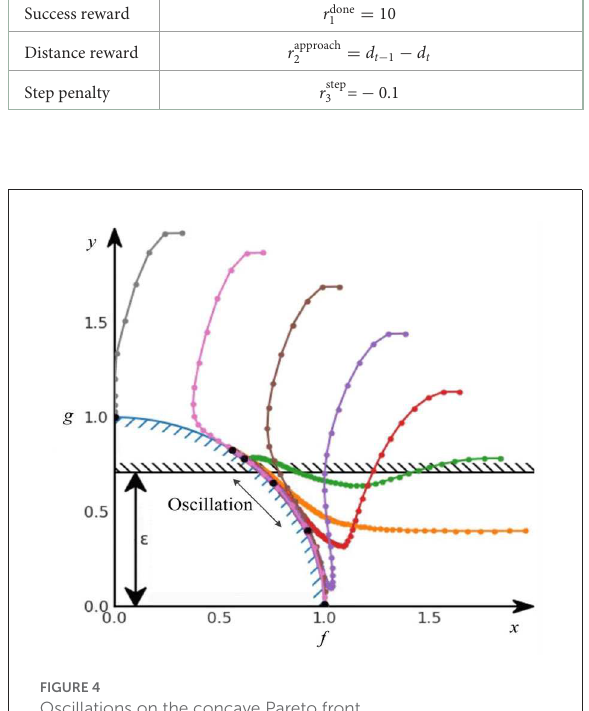
FIGURE4 Oscillations on the concave Pareto